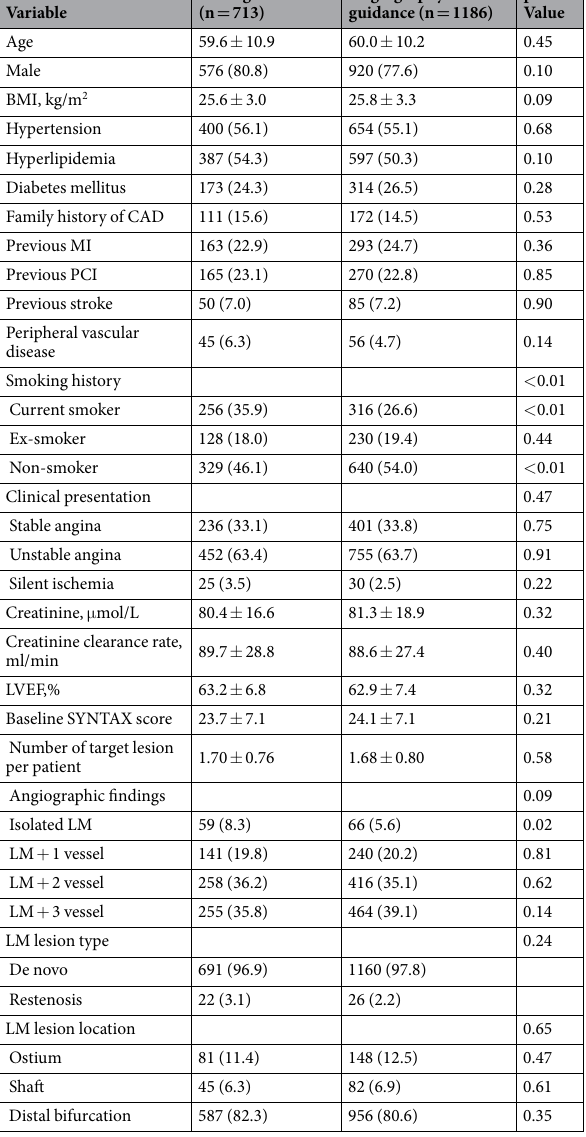
Table 1. Baseline Patient and Lesion Characteristics. Values are mean ± SD or n (%). BMI = body mass index; CABG = coronary artery bypass graft; CAD = coronary artery disease; IVUS = intravascular ultrasound; LM = left main; LVEF = left ventricular ejection fraction; MI = myocardial infarction; PCI = percutaneous coronary intervention; SYNTAX = synergy between PCI with TAXUS and cardiac